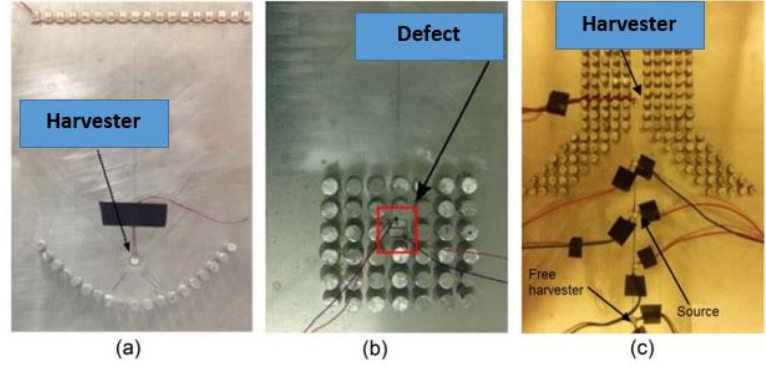
Figure 21. PEH configurations: ( a ) parabolic acoustic mirror; ( b ) point defect; and ( c ) acoustic funnel [256].